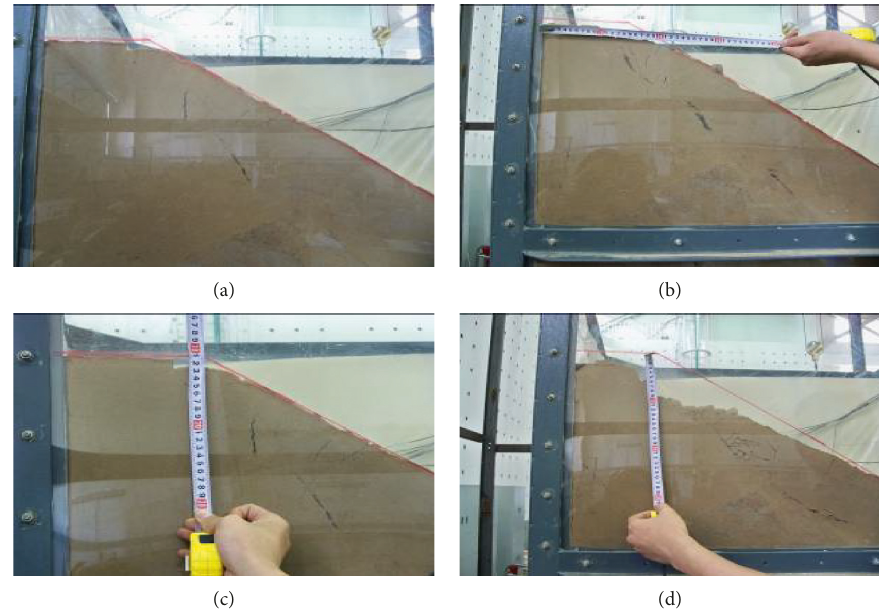
Figure 11: Permanent displacements during the test. (a) H